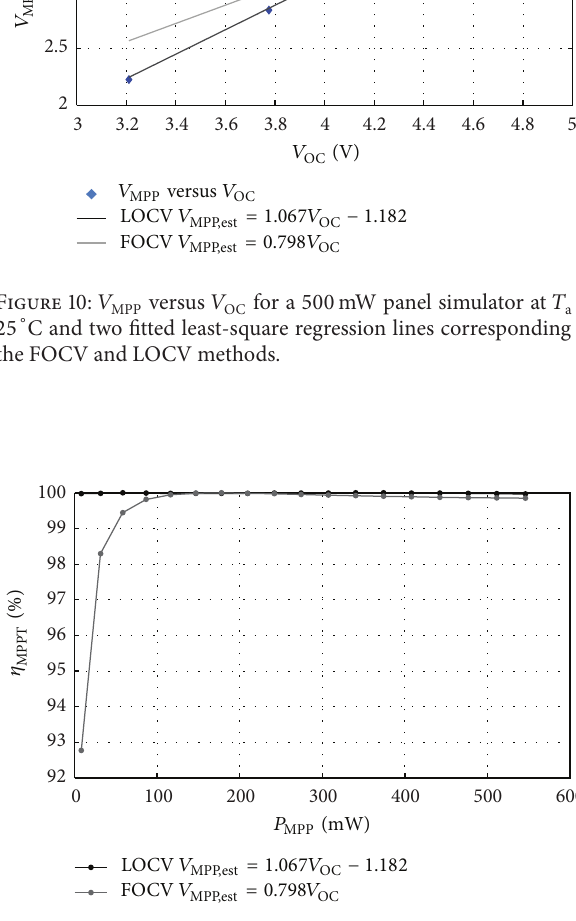
Figure 11: Experimental 𝜂 versus 𝑃 by using the FOCV MPPT MPP method (grey line), with 𝑘 = 0.798 , and the LOCV method (black line), with 𝑎 = 1.0674 and 𝑏 = −1.182 , for a 500 mW PV